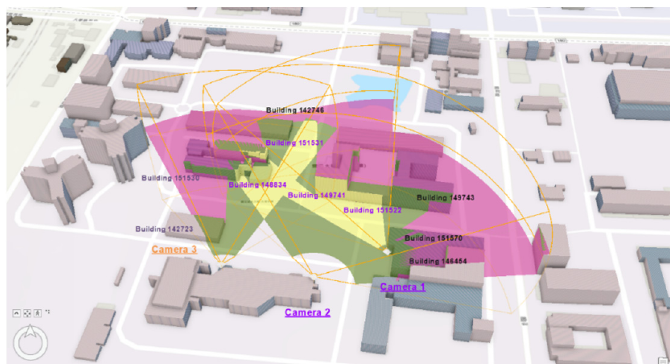
148834 Table 6. Camera 2 CCTV’s metadata designed. Metadata